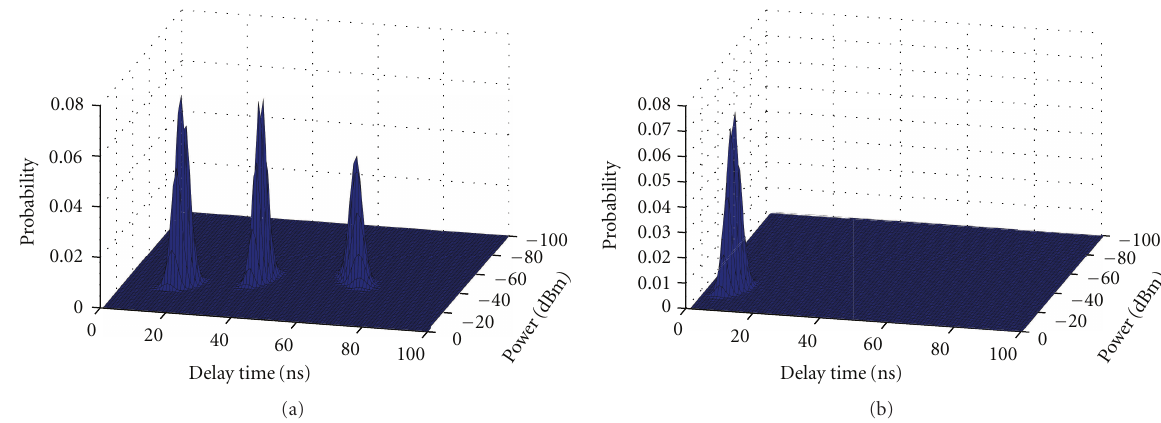
Figure 13: 2GHz omni-directional antenna measurements with people (a) fitted, (b) measured